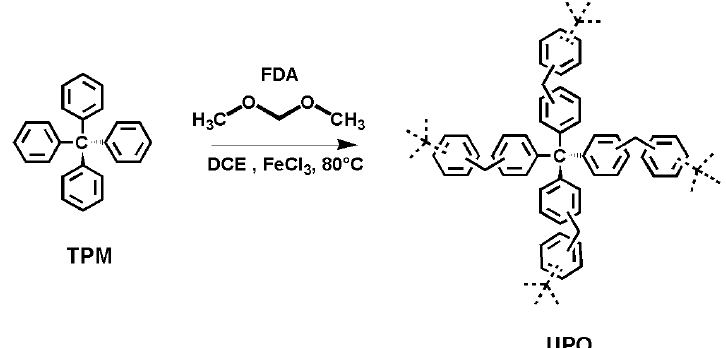
Figure 1. Scheme of the synthesis of UPO materials.